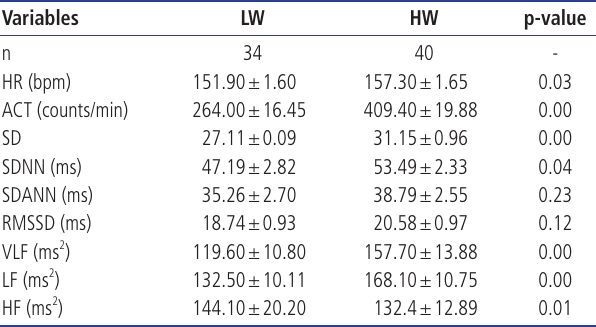
Table 3. General comparison in HR, ACT, and HRV variables between LW and HW groups during isolation test Variables